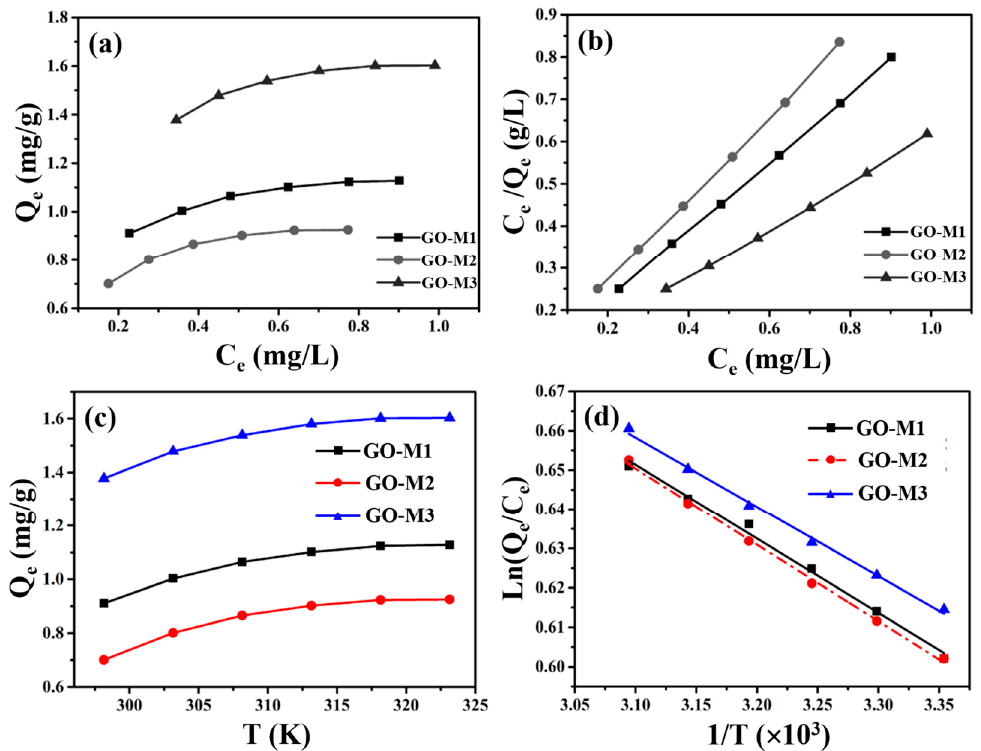
Figure 8. Adsorption isotherms at 298.15 K ( a ) and linear fitting of Langmuir model ( b ) for Cr(VI) adsorption by GOs; the relationship between the equilibrium adsorption capacity of GOs for Cr(VI) removal and temperature ( c ) and the relationship between Ln(Q e /C e ) and 1/T ( d ).